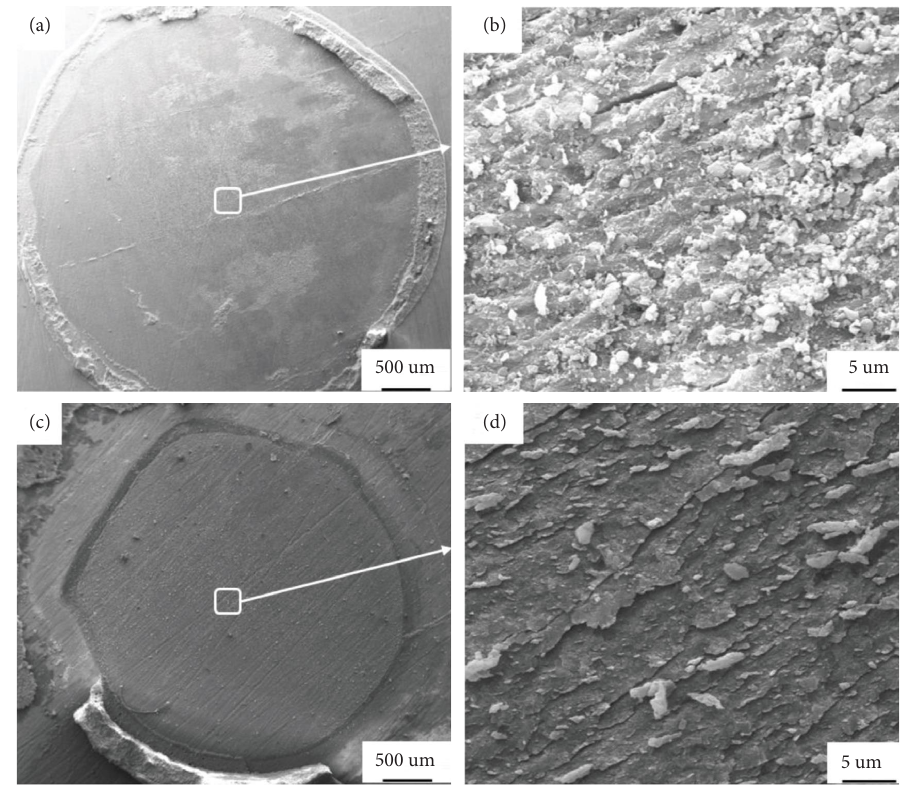
Figure 2: SEM images of the fracture interface for diferent bond strength on dentin: (a and b) 15MPa, (c and d) 5MPa. Table 3: Shear bond strengths of various groups (MPa).